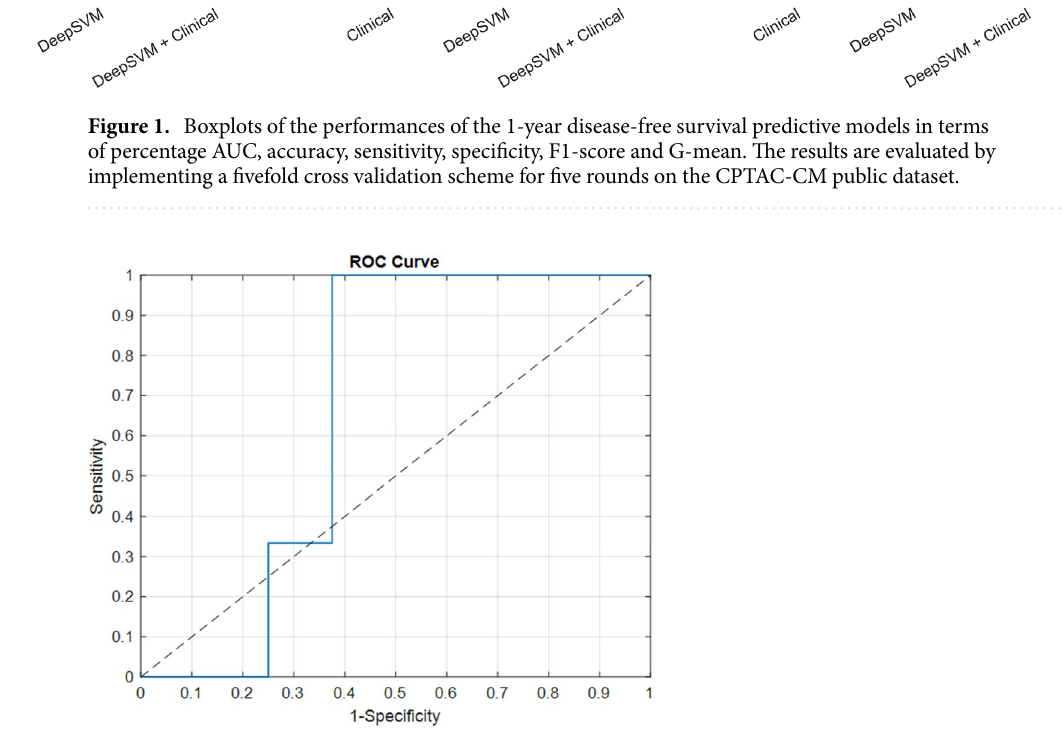
Figure 2. ROC Curve related to the DeepSVM model on the validation cohort. The dotted line represents the random